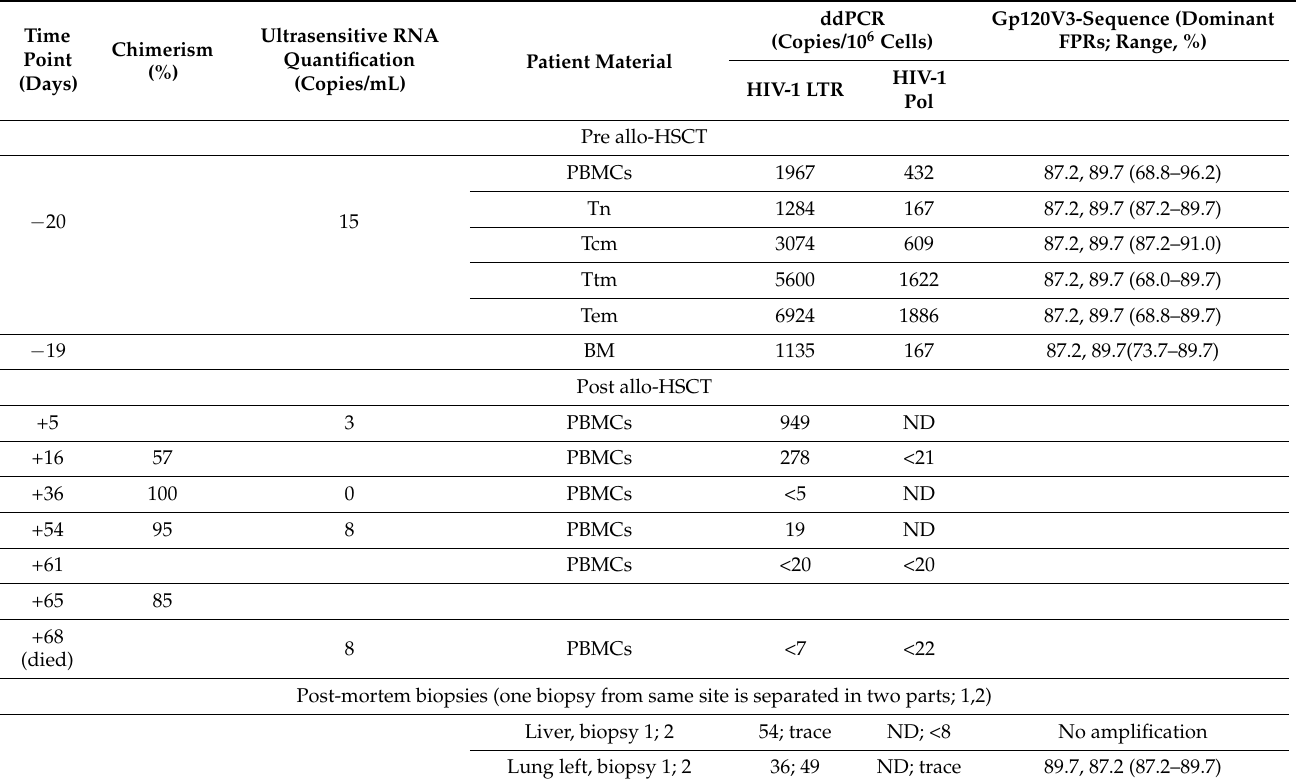
Table 2. Results of HIV-1-DNA quantification and characterization in patient